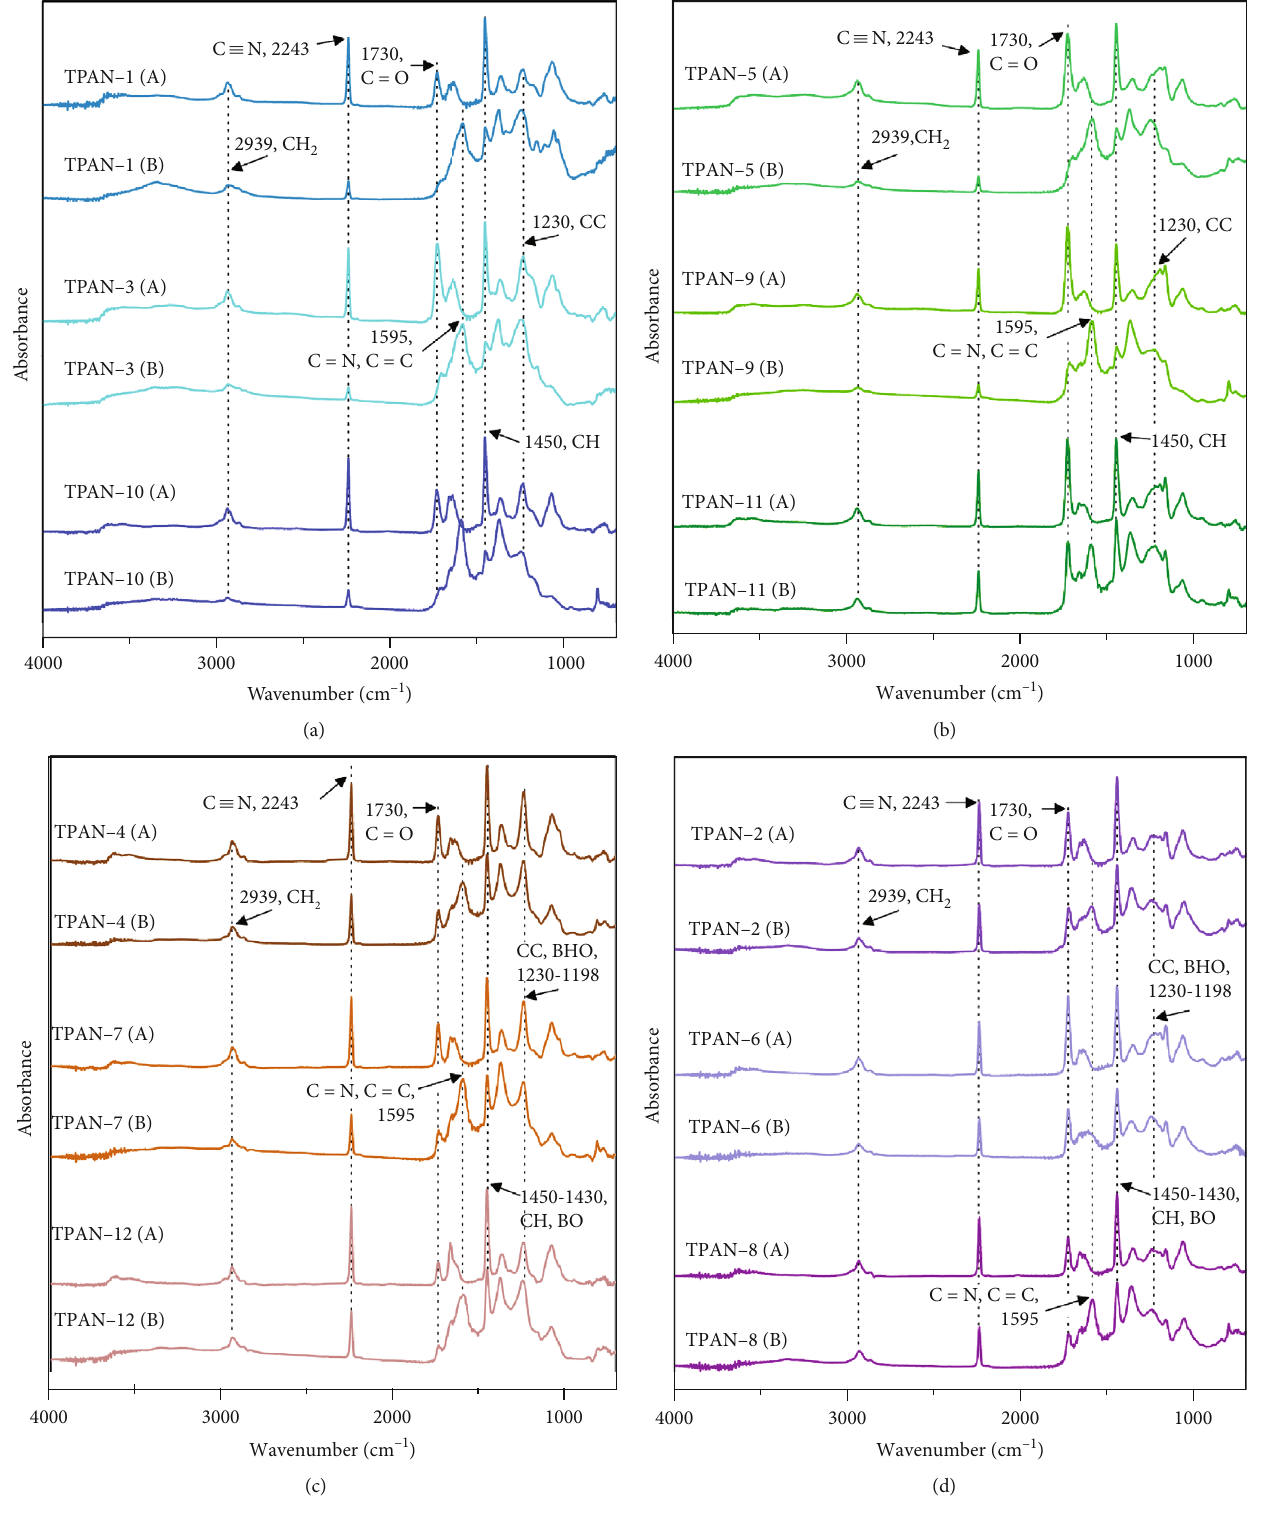
Figure 4: FTIR spectra of TPAN samples: (a) [P(AN-IA-VA)]; (b) [P(AN-IA-MA)]; (c) [P(AN-BA-VA)]; (d) [P(AN-BA- MA)], (A) original and (B) heated at 220 ° C for 0.5h,